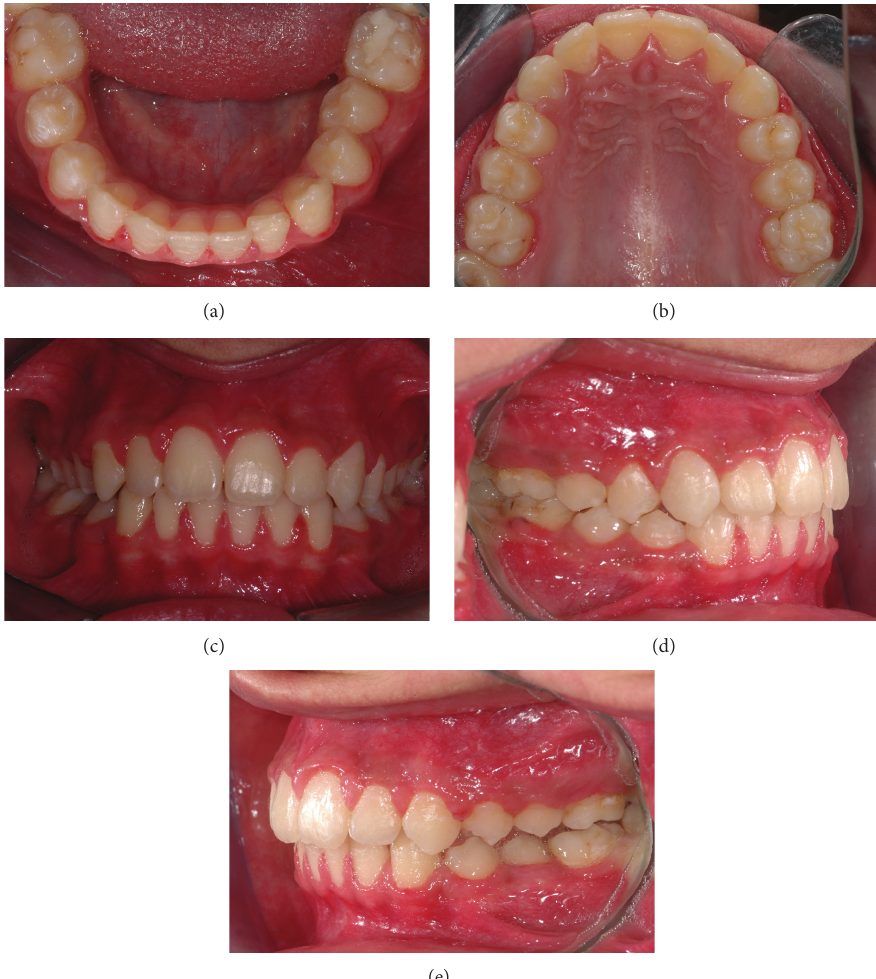
Figure 8: (a–e) Intraoral views of the patient after completion of orthodontic treatment.